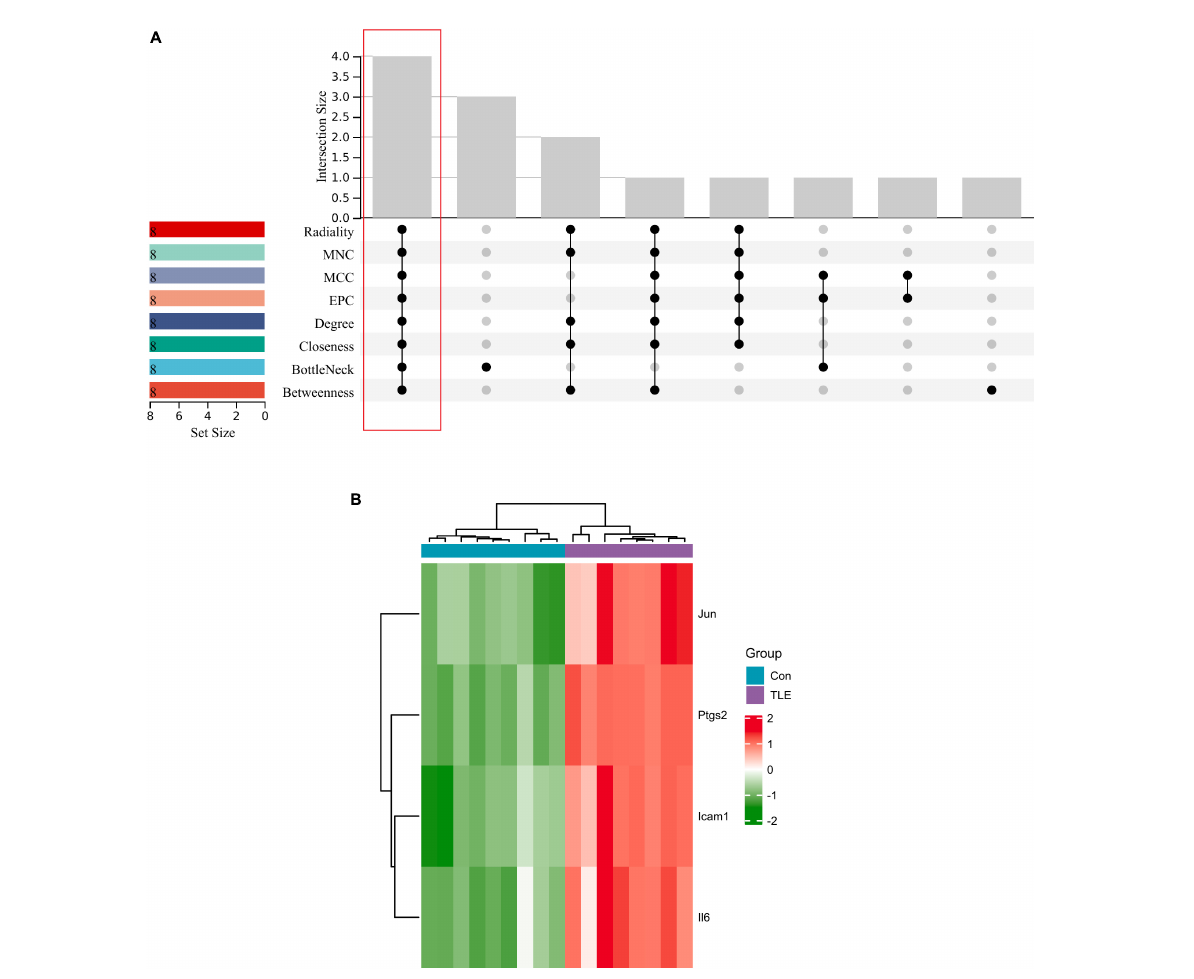
FIGURE3 Identification of hub genes. (A) Eight algorithms were applied to identify hub genes based on the R package “UpSet.” Four IRGs (Ptgs2, Jun, Icam1, Il6) were identified as hub genes. (B) Heatmap of four hub genes (Ptgs2, Jun, Icam1, Il6) in the GSE88992 dataset. Red indicates up-regulated and green indicates down-regulated. The results showed that Ptgs2, Jun, Icam1, Il6 expression levels were all up-regulated in TLE group.